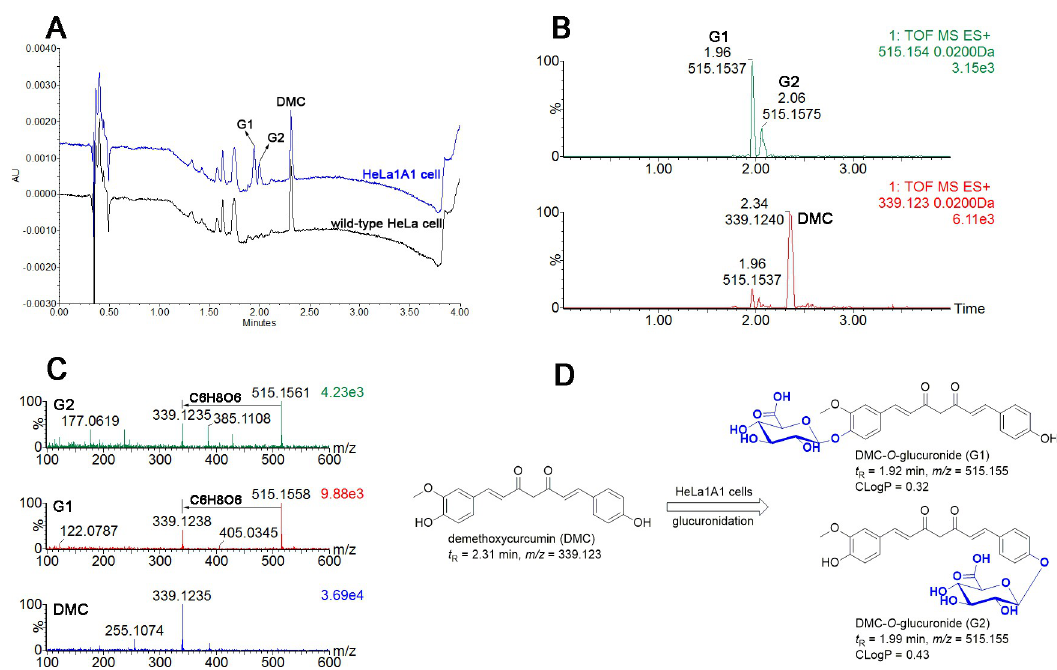
Fig 1. Liquid chromatography tandem mass spectrometry analysis of demethoxycurcumin and demethoxycurcumin- O - glucuronides. (A) Ultra high-performance liquid chromatography chromatograms of demethoxycurcumin and demethoxycurcumin- O -glucuronides (G1 and G2) generated in wild-type HeLa cells and HeLa1A1 cells; (B) Extracted ion chromatograms of demethoxycurcumin and demethoxycurcumin- O -glucuronides (G1 and G2); (C) ESI-MS/MS spectra of demethoxycurcumin and demethoxycurcumin- O -glucuronides (G1 and G2) in positive ion mode; (D) Glucuronidation pathways of demethoxycurcumin by HeLa1A1 cells.